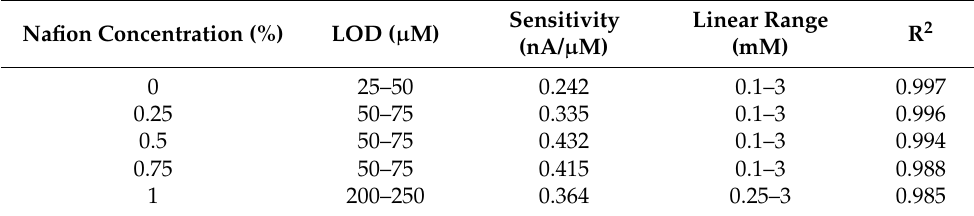
Table 1. The performance of PaperLIG-based glucose biosensor prepared with various Nafion solution concentrations. Nafion Concentration (%) LOD ( µ M)